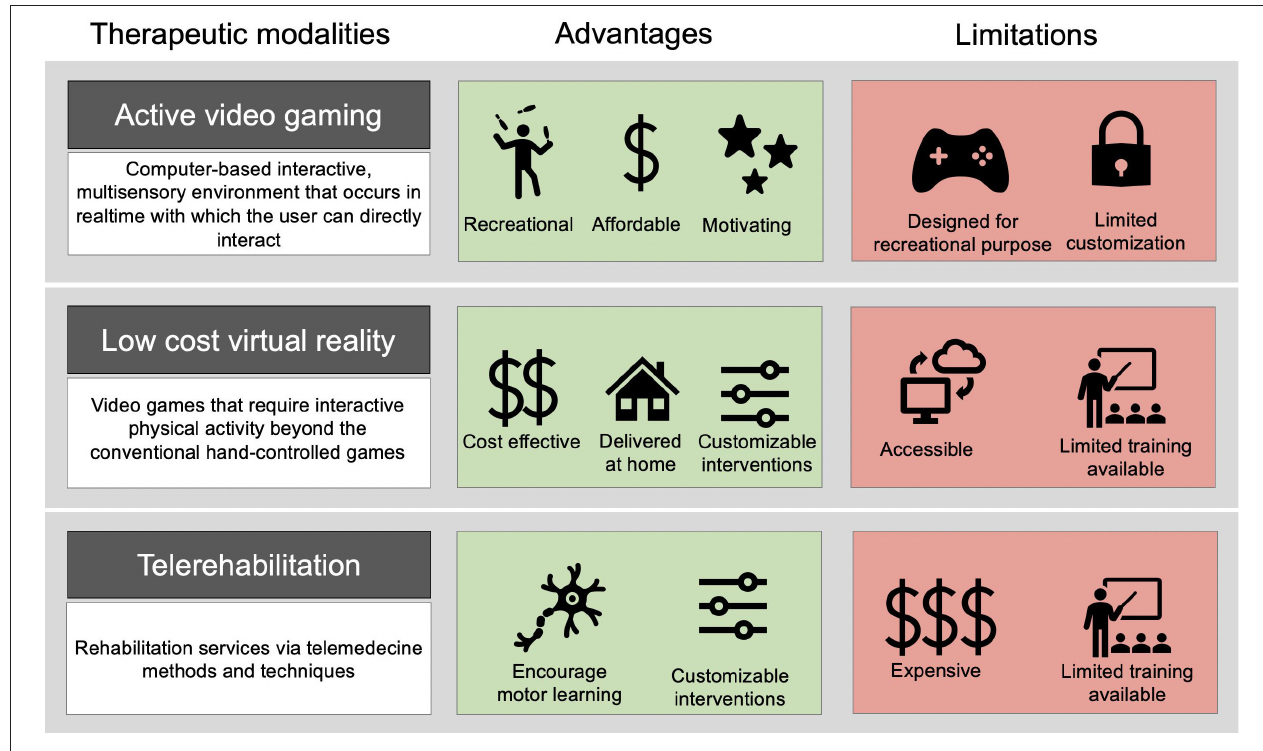
FIGURE 1 | Advantages and limitations of various therapeutic modalities. From left to right: Definition of the therapeutic modalities; list of advantages; list of disadvantages. The combination of AVG/VR with telerehabilitation can be useful to target motor learning principles, such as task-specificity and motivation, to ultimately individualized interventions delivered at home and minimize limitations. We acknowledge that combining these 3 therapeutic modalities can still present limitations, such as limited training for clinicians. Resources such as the Classification Framework by Gavin and Levac (46) can help to address common